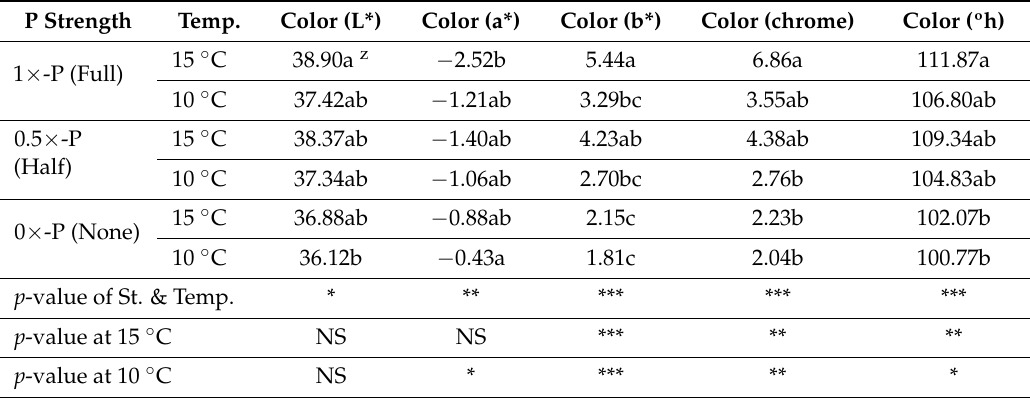
Table 6. Leaf color value (L*, a*, b*, chrome and ºh) of red romaine lettuce at harvest day (28 days after treatment).